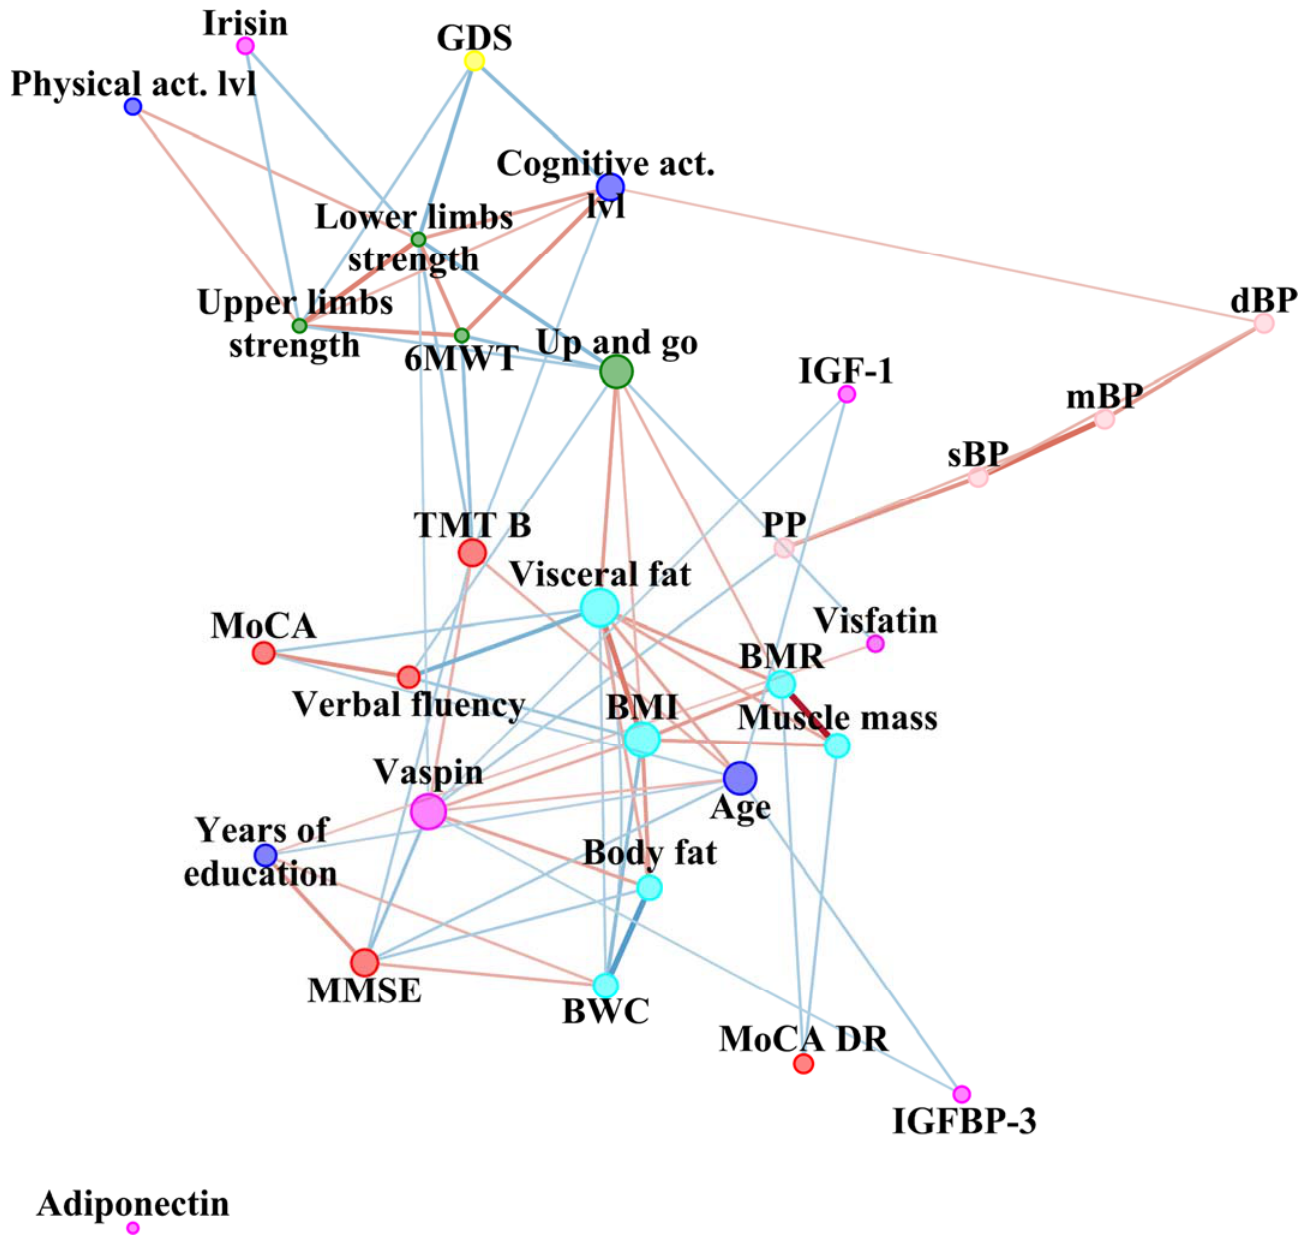
Figure 2. Network analysis in PMHTN group. sBP—systolic blood pressure, dBP—diastolic blood